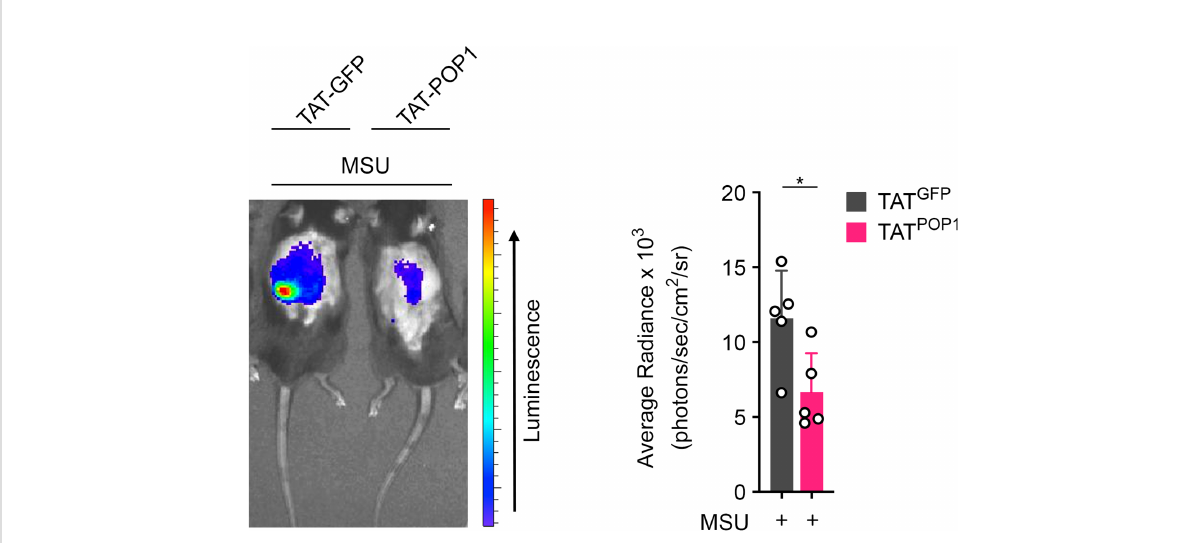
FIGURE 6 Cell penetrating POP1 ameliorates gout. In vivo imaging of MPO activity correlating to MSU-induced neutrophil in fi ltration into subcutaneous air pouches 4h after MSU crystal injection in wild type mice injected with either TAT-GFP or TAT-POP1 30 minutes prior MSU crystal injection (left) and average radiance (right) presented as photons/sec/cm 2 /sr (n = 5 ± s.d.). *p <